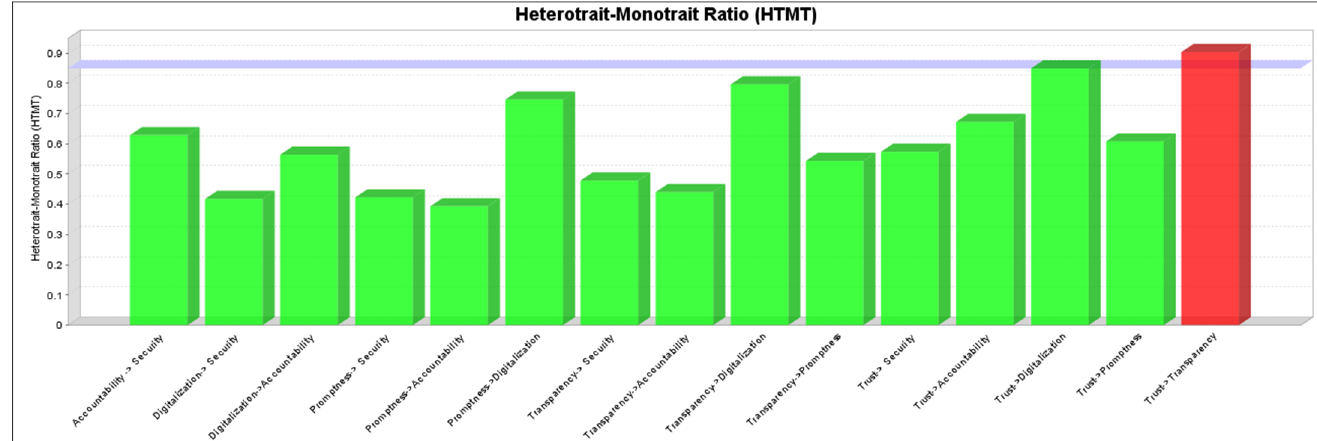
Figure 4. HTMT’s Discriminant Validity Analysis. Table 4. Path analysis using